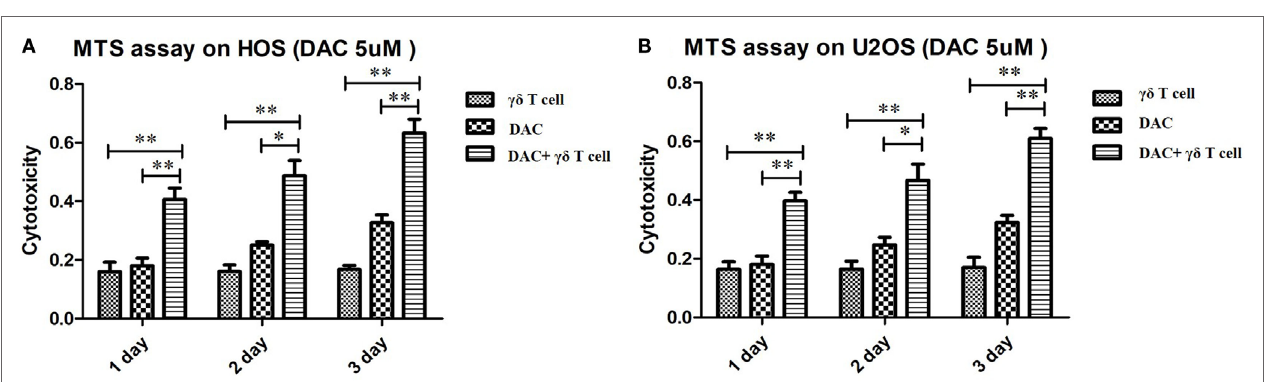
FigUre 2 | Cytotoxic assay using MTS method to evaluate the cytotoxic effects of γδ T cells on osteosarcoma (OS) cells pretreated with decitabine (DAC) (5 µM). (a) MTS assay on HOS cells. Treatment with γδ T cells or DAC alone slightly inhibited the growth of HOS cells. However, γδ T cells showed more efficiency in combination with DAC pretreatment for 1, 2, and 3 days. (B) MTS assay on U2OS cells. Similar to the results of HOS cells, DAC treatment can significantly enhance γδ T cells immunotherapy against OS cells. For (a) and (B) , samples were run in triplicates. Error bars show standard deviation among the replicates. ( γδ T cell: tumor cell = 5:1; * P < 0.05; ** P < 0.01).